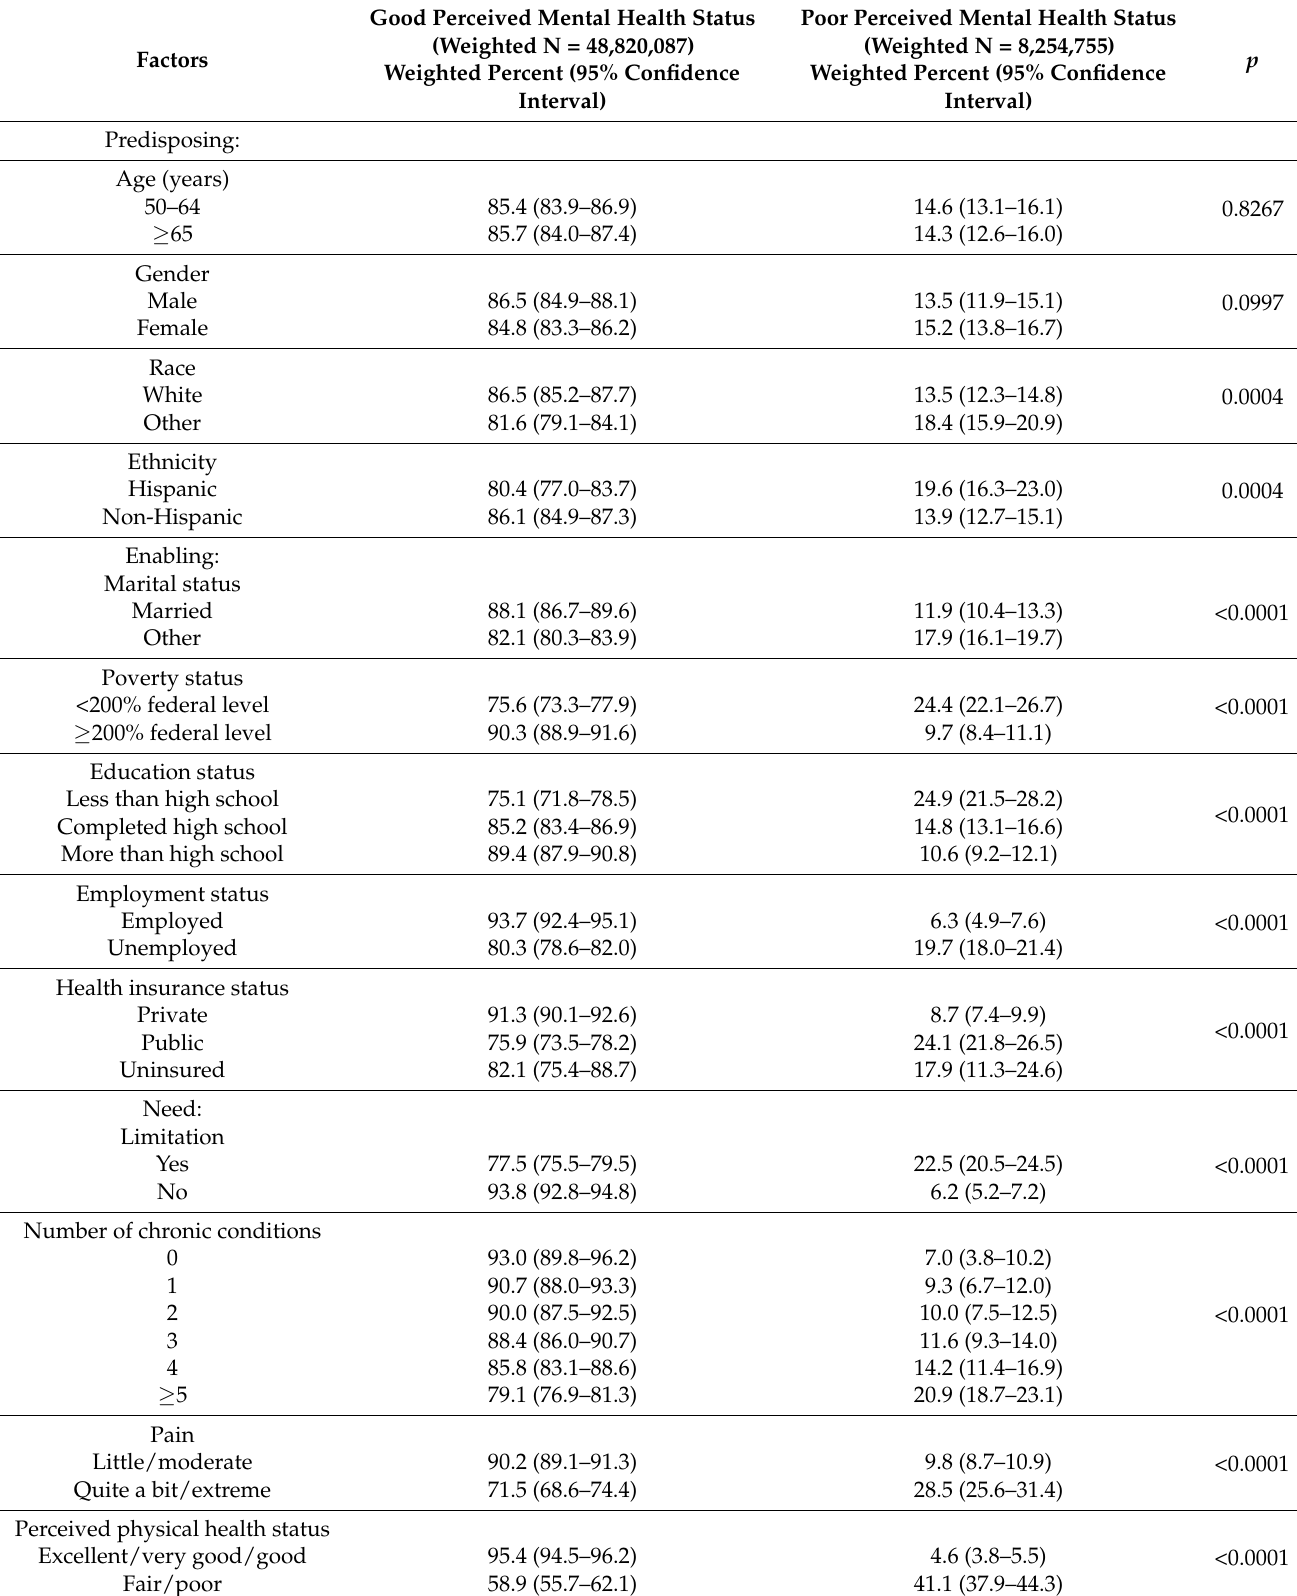
Table 1. Characteristics of older United States adults (age ≥ 50 years) with self-reported pain in the past four weeks, stratified by good and poor perceived mental health